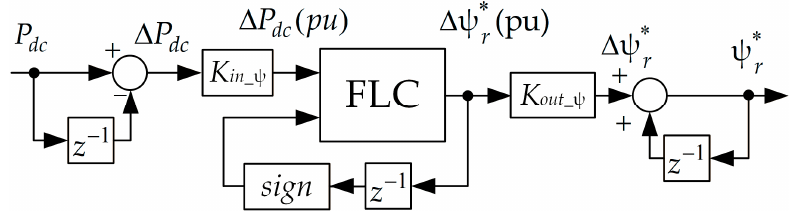
Figure 8. Block diagram of the FL-based SCIG MPPT algorithm.